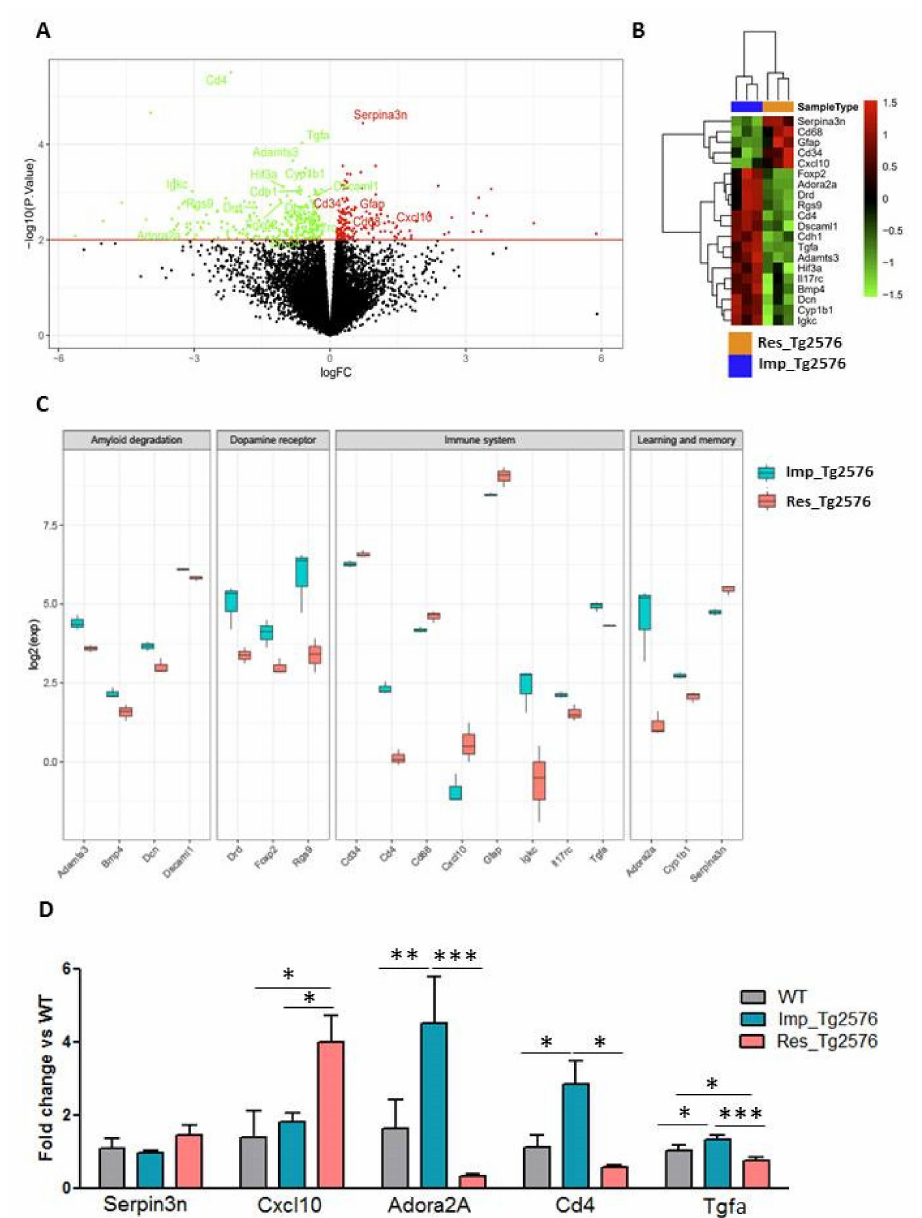
Figure 2. Genes and pathways dysregulated in the prefrontal cortex of cognitive resilient Tg2576 mice by RNA seq. ( A ) Volcano plot of expressed genes in resilient and impaired Tg2576 mice. Fold change between both groups of samples (x axis) is plotted against statistical significance (y axis) for each gene. Genes upregulated with p < 0.01 are depicted in red, and those downregulated with p < 0.01 are shown in green. ( B ) Heat map illustrating the most significant differentially expressed genes between resilient and impaired mice. Red represents genes with positive log fold-change (log FC), indicating higher expression in resilient compared to impaired mice. Green indicates negative log FC and thus lower expression in cognitive resilient vs. demented mice. ( C ) Box plot of log2 values of the expression of selected transcripts across resilient and impaired Tg2576 mice. ( D ) Prefrontal-cortex mRNA levels of certain selected markers involved in inflammation, learning, and memory that were detected by qRT-PCR in WT, Imp_Tg2576 and Res_Tg2576 mice (one way ANOVA test followed by Newman-Kewls post hoc test, n = 3–4, * p ≤ 0.05, ** p ≤ 0.01, *** p ≤